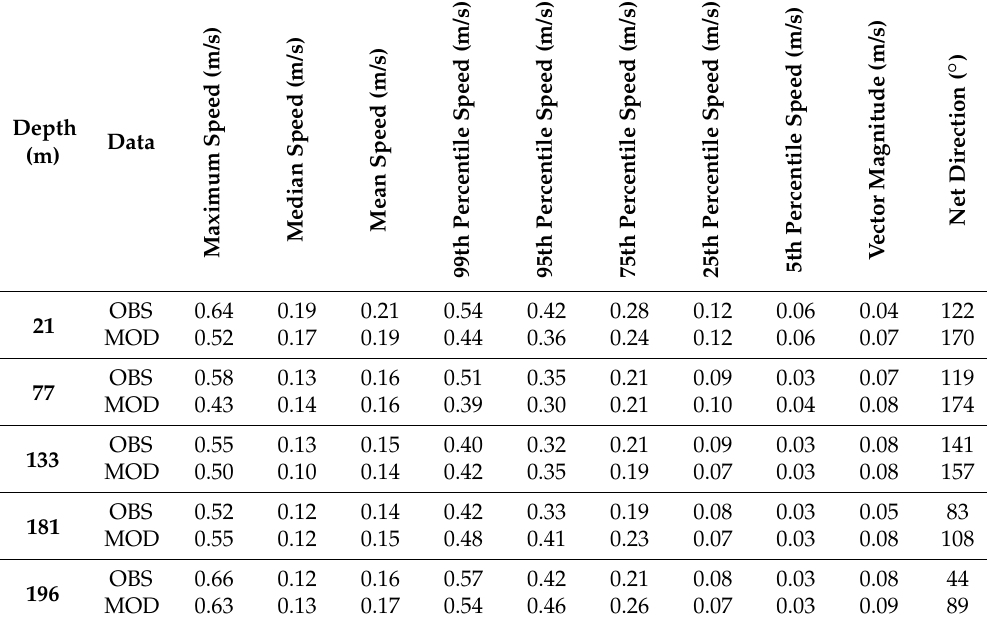
Table 2. Summary of statistics for the modeled and observed current speeds for the maximum, median, and mean values from 1 November to 31 December 2014, showing the percentile exceedance